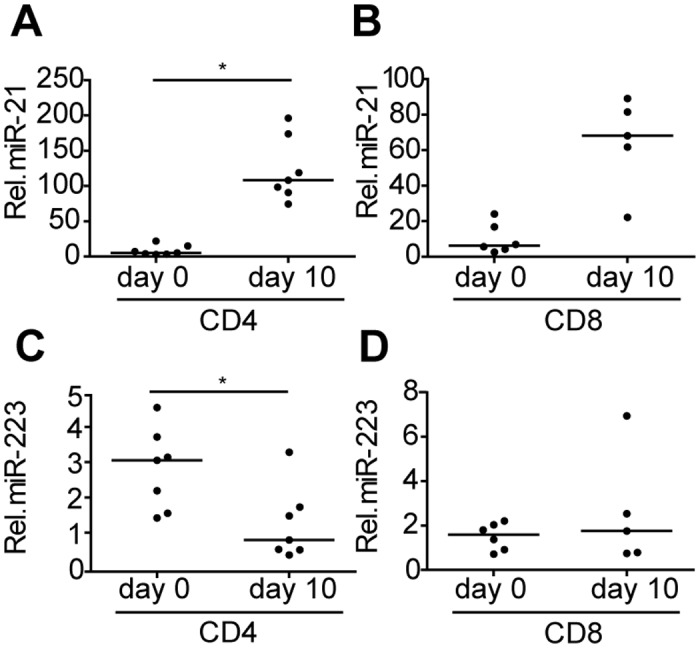
T-cell activation induces upregulation of miR-21 and downregulation of miR-223.Relative expression of miR-21 in stimulated (A) CD4+CD45RO- and (B) CD4-CD45RO- T cells. Relative expression of miR-223 in stimulated (C) CD4+CD45RO- and (D) CD4-CD45RO- T cells. MiRNA expression was normalized to the expression of RNU49 (line indicates median). *p<0.05.